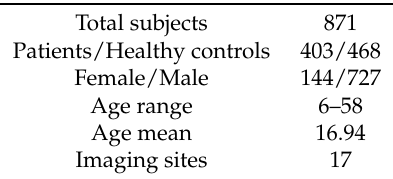
Table 1. The statistics of the Autism Brain Imaging Data Exchange (ABIDE) dataset that was used in this